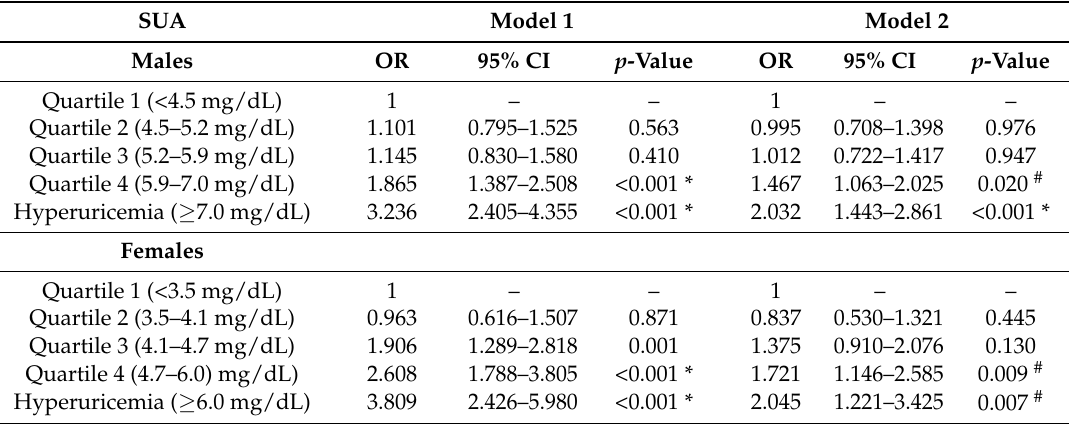
Table 3. Multiple logistic regression for elevated